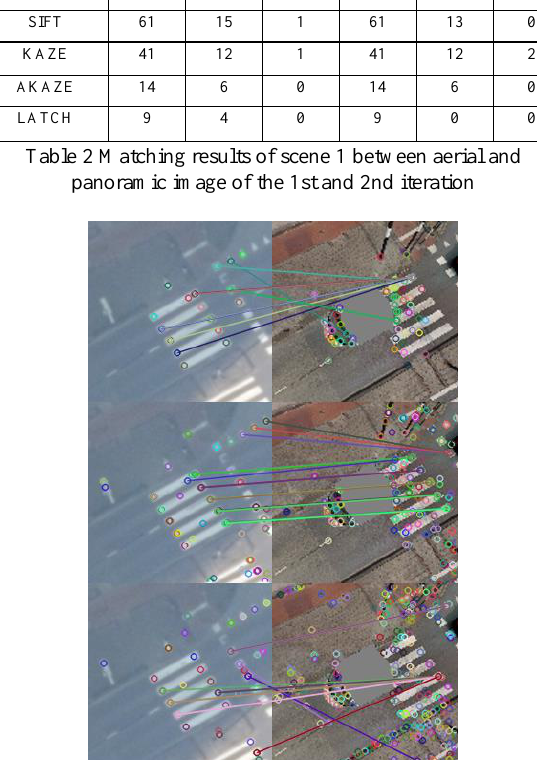
Figure 10 Comparison of matching results of AKAZE (top), KAZE (centre) and SIFT (bottom) in 3 rd run of the 1 st scene